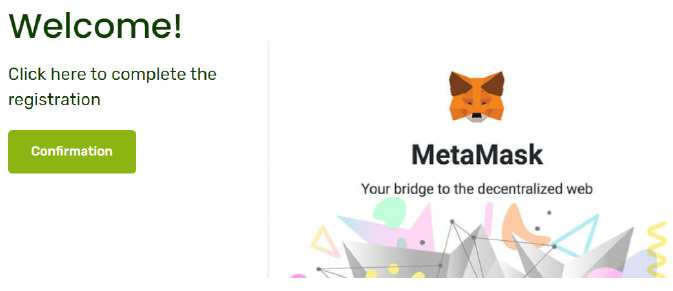
Figure 4. User interface of IG .